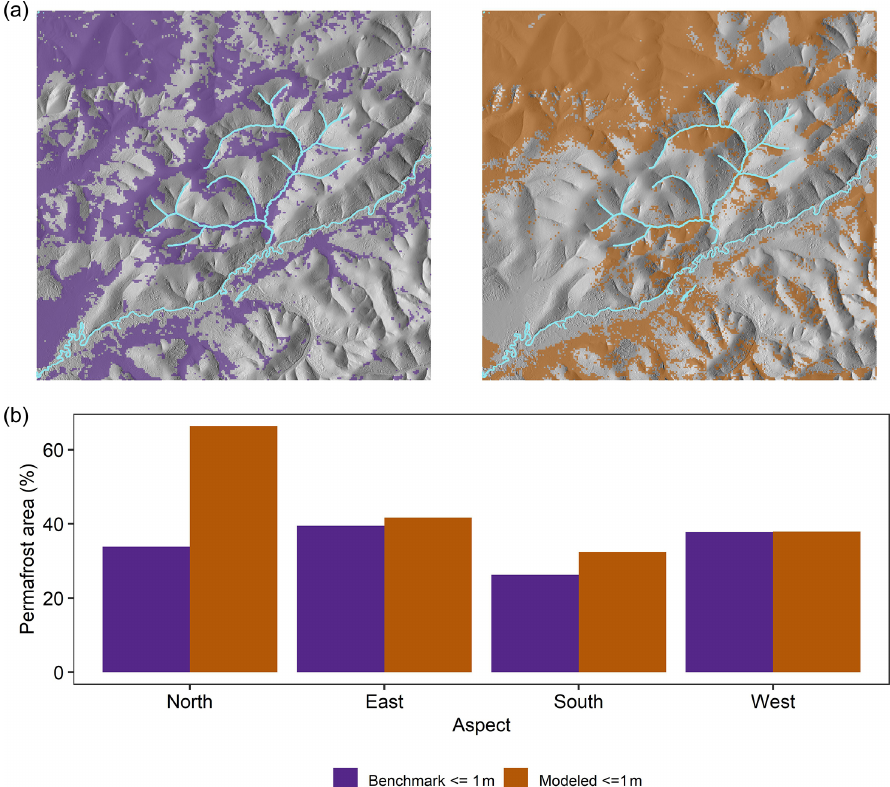
Figure 5. (a) Observed and simulated near-surface ( ≤ 1m deep) permafrost in a 61000ha forested landscape in interior Alaska. (b) Ob- served and simulated percent of forested area underlain by near-surface permafrost in the same landscape as a function of aspect. Simulated permafrost presence is for years 261–300 of the simulation. Benchmarking product is derived from years